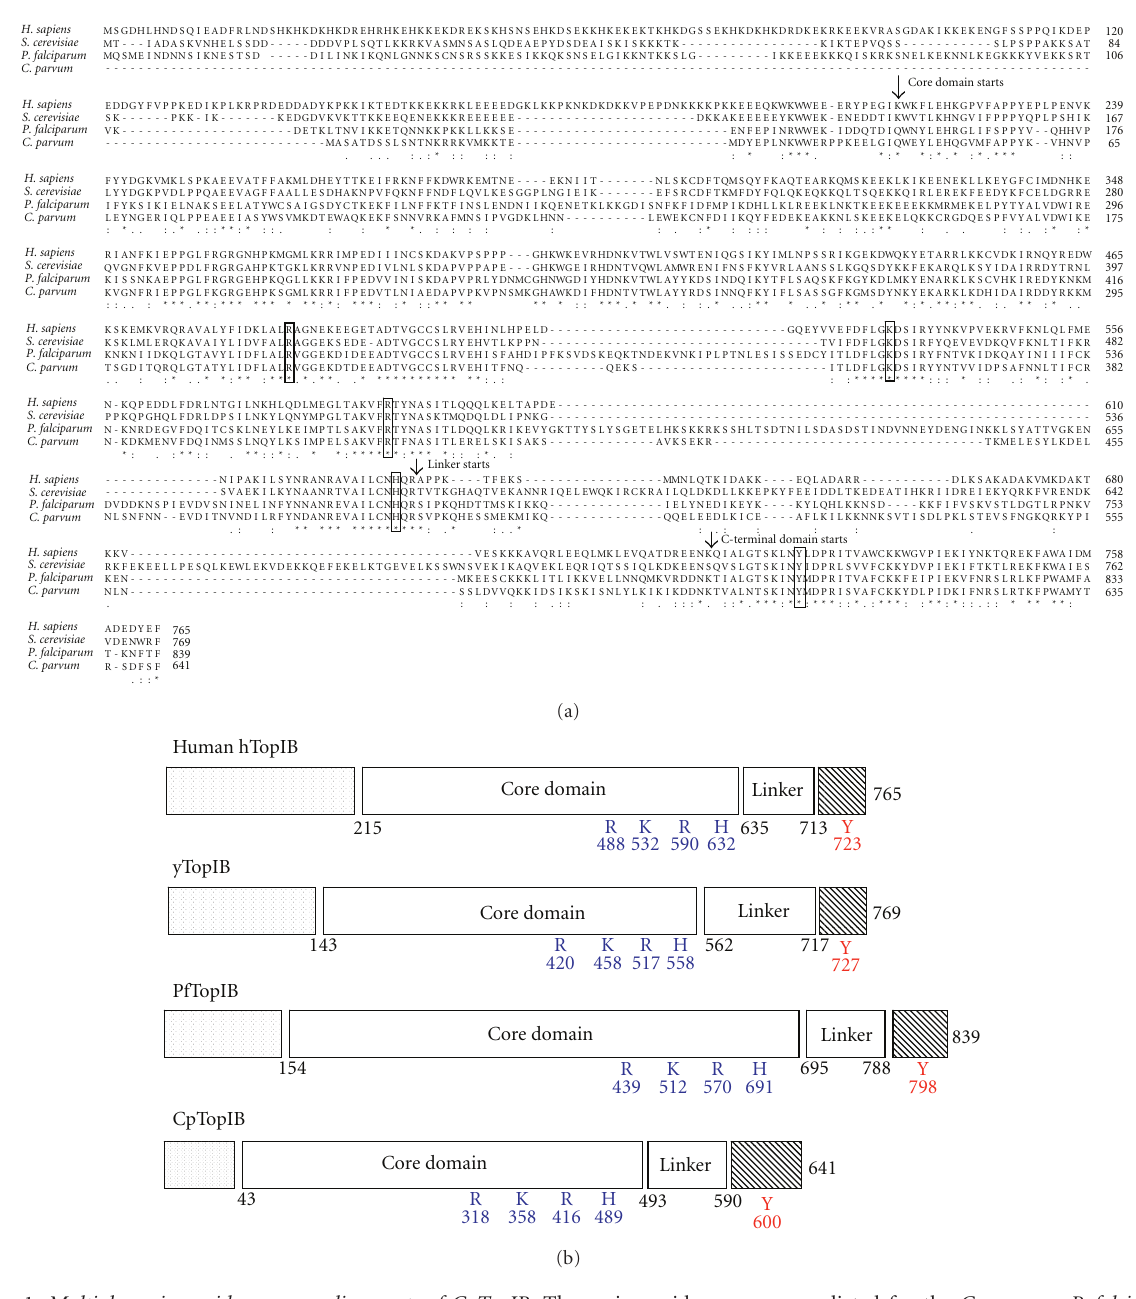
Figure 1: Multiple amino acid sequence alignments of CpTopIB . The amino acid sequences predicted for the C. parvum , P. falciparum , S. cerevisiae , and human topoisomerases were aligned using the ClustalX multiple sequence alignment program. Symbols : “ ∗ ” represents identical or conserved residues in all sequences in the alignment, “:” conserved substitutions and “.” semiconserved substitutions. Complete genomic sequences of MAT proteins are available in GenBank, for S. cerevisiae accession number (K03007), P. falciparum (X83758), human (J-03250), and C. parvum (XM-628497). Arrowheads represent the points where a protein domain